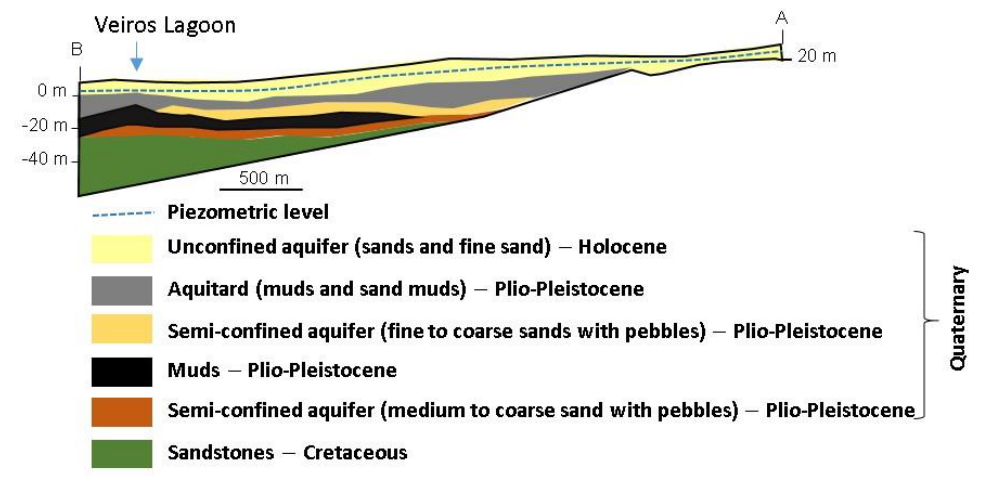
Figure 2. Simplified vertical profile (section AB marked in Figure 1) of the main units of the Quaternary aquifer system in the Estarreja region (adapted [33]). The vertical-to-horizontal scale ratio is 10:1.